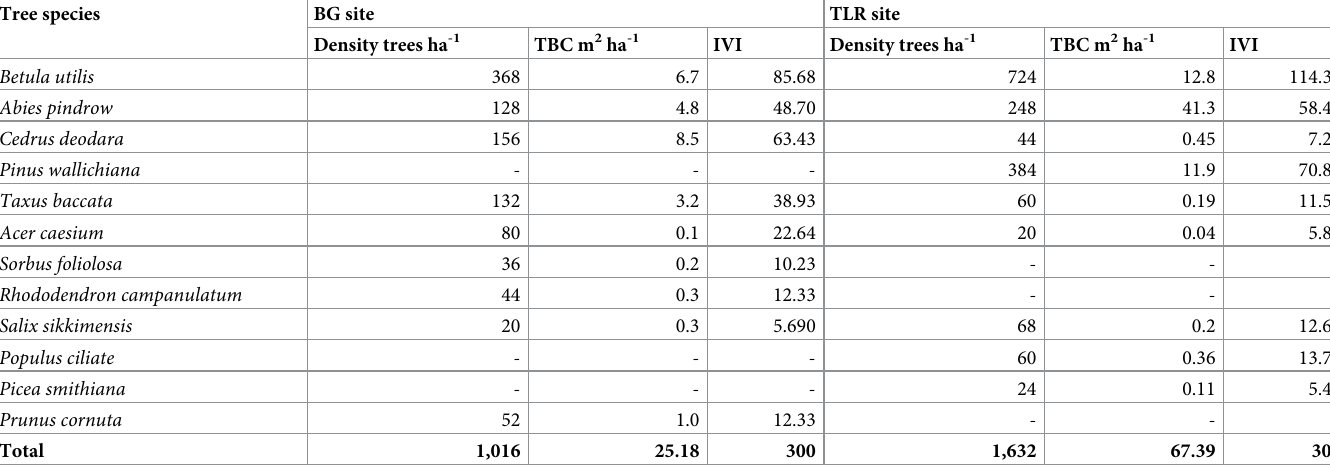
Table 2. Phytosociological parameters of tree species around temperate zone of Nanda Devi Biosphere Reserve, Western Himalaya. Tree